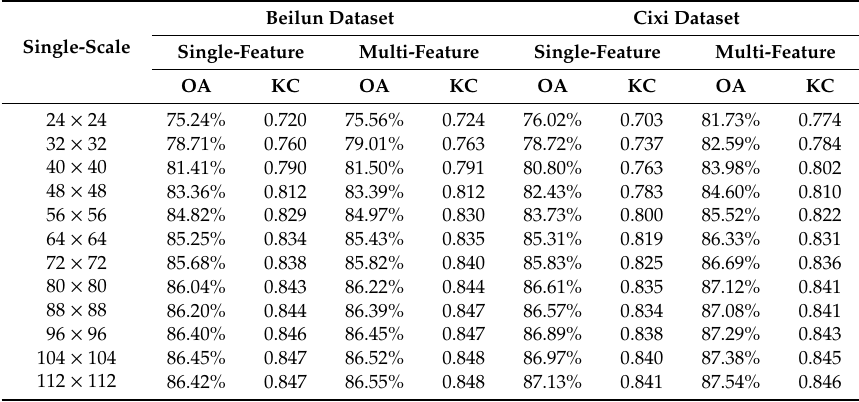
Table 14. Classification accuracy comparison between single-feature and multi-feature methods based on single